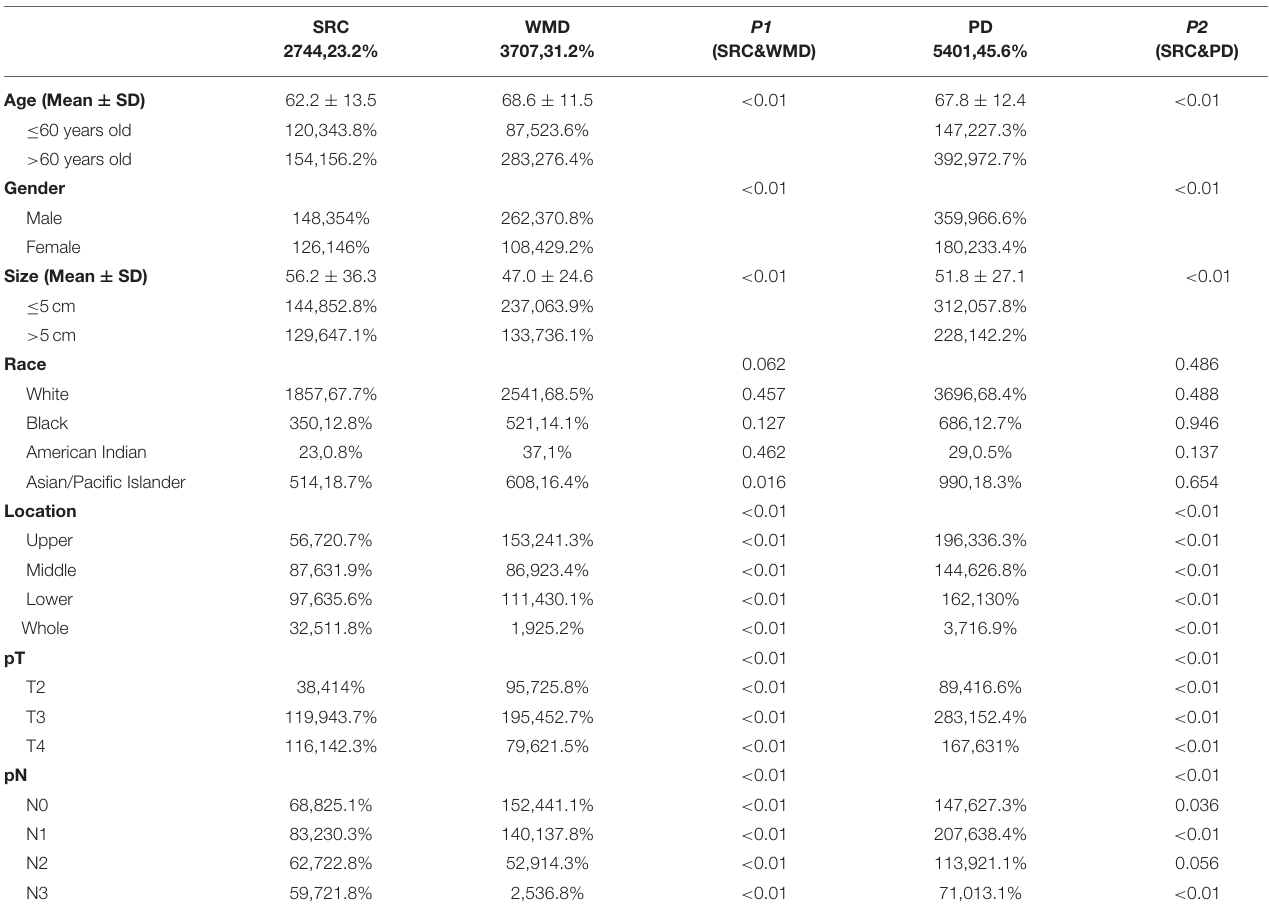
TABLE 2 | Comparison of clinicopathological characteristics in advanced gastric cancer.